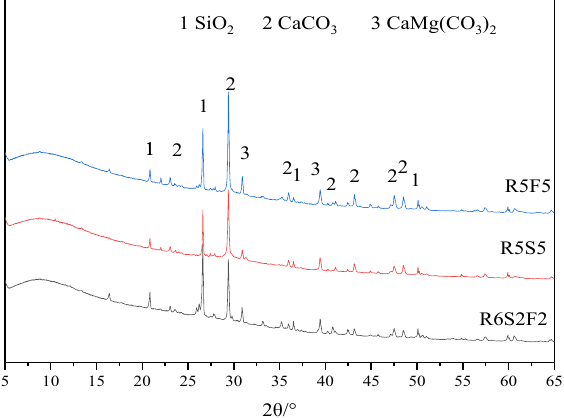
Figure 11. XRD of AARCPC with different mineral admixtures content.